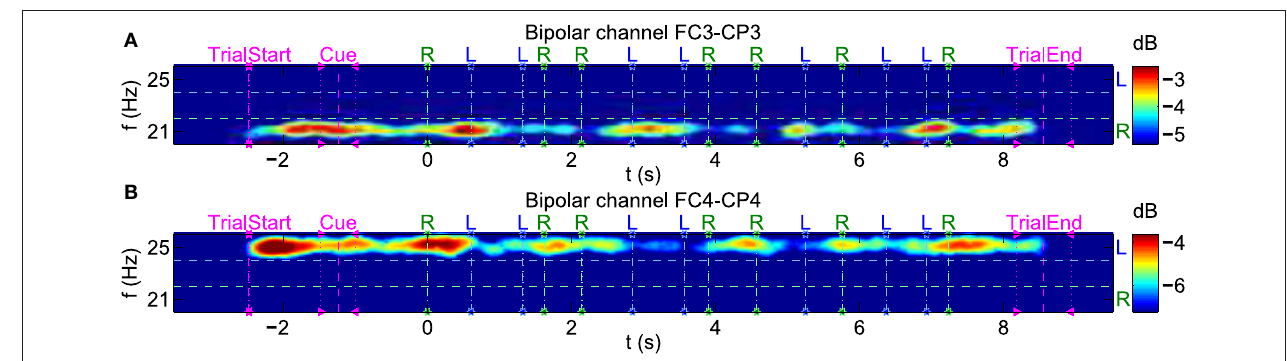
FIGURE 10 | Visualization of transient effects in the SSSEP. Spectrograms for the bipolar channels (A) FC3-CP3 and (B) FC4-CP4 of subject s01 as in Figure 7 , but with shorter time windows (1s window length, 0.95s window overlap) and individual trials aligned to each first twitch’s position. The color axes were scaled to highlight variations at each stimulation frequency. Twitch onsets at left (L) and right (R) index fingers are drawn as vertical dashed lines.